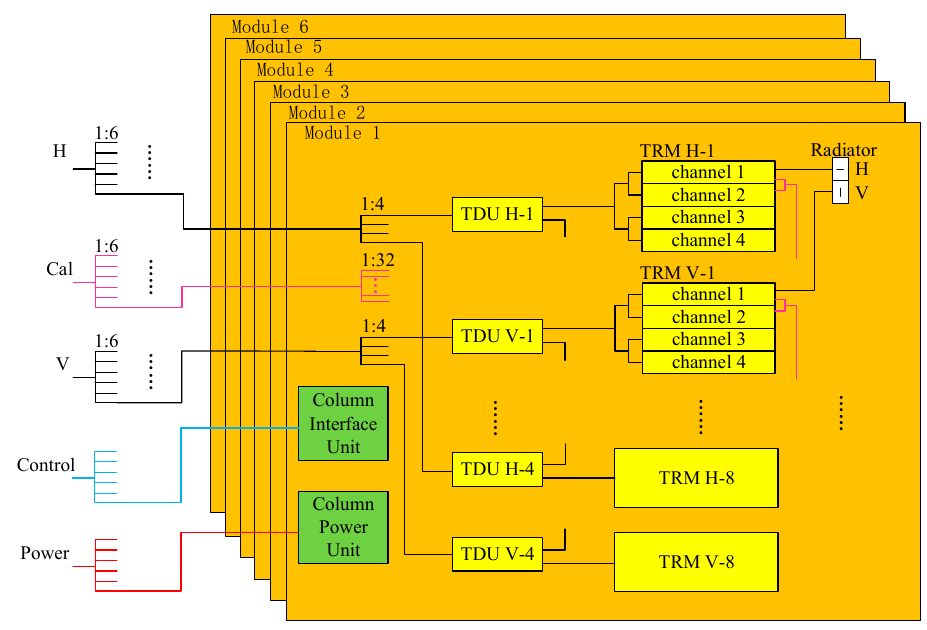
Figure 4. The electric block diagram of one antenna panel.